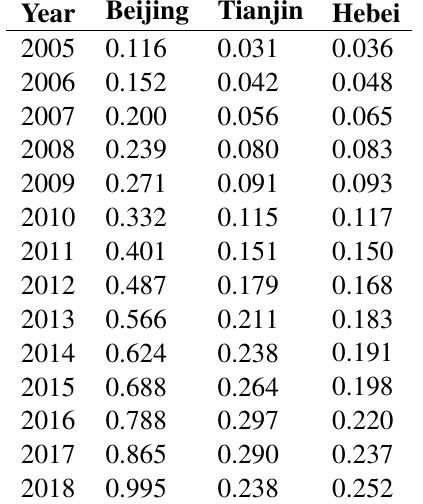
Table 6 Standardised policy output values of the Beijing–Tianjin–Hebei region